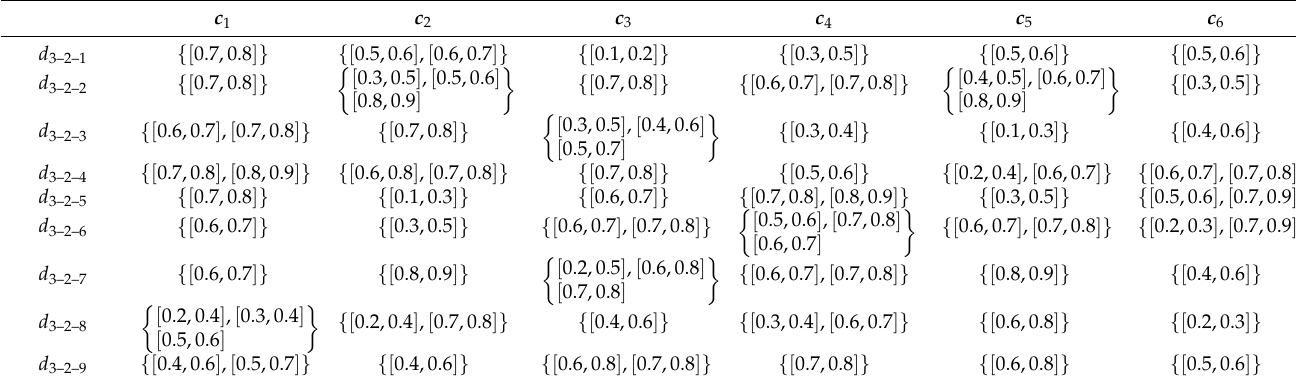
Table A15. Scoring matrix of social environment d 3–2 .